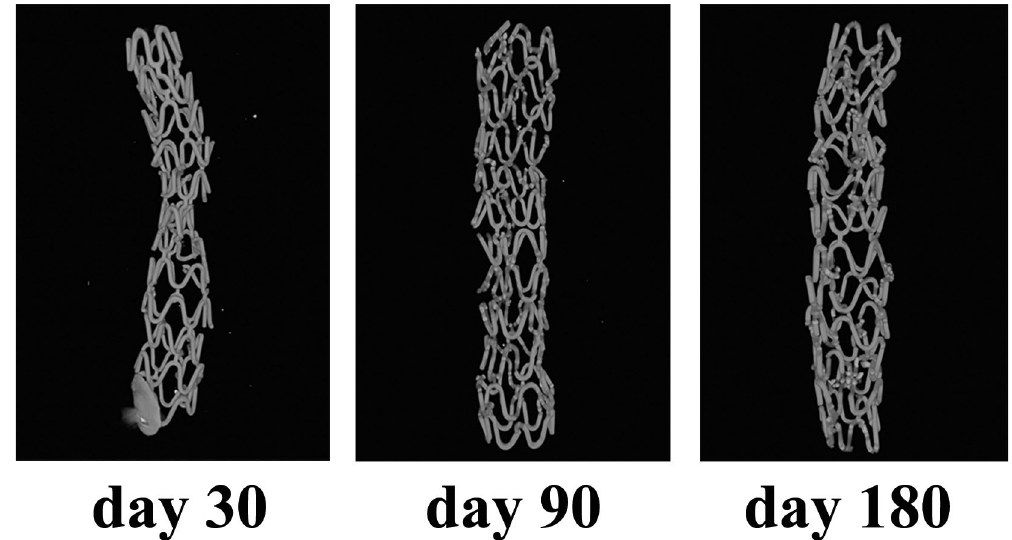
Figure 5. Micro-CT results of residual JDBM BRS at 30, 90, and 180 days post implantation. The stent still maintained good integrity at 30 days. Though some struts had transferred from the metal to degradation products, the main structure of the JDBM BRS stent remained intact at 90 and 180 days. The raw image data were reconstructed using the NRecon software V1.4.4.